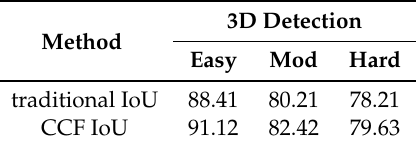
Table 3. Ablation study of center 3D IoU loss nodule in different stages. The results are reported on the KITTI validation